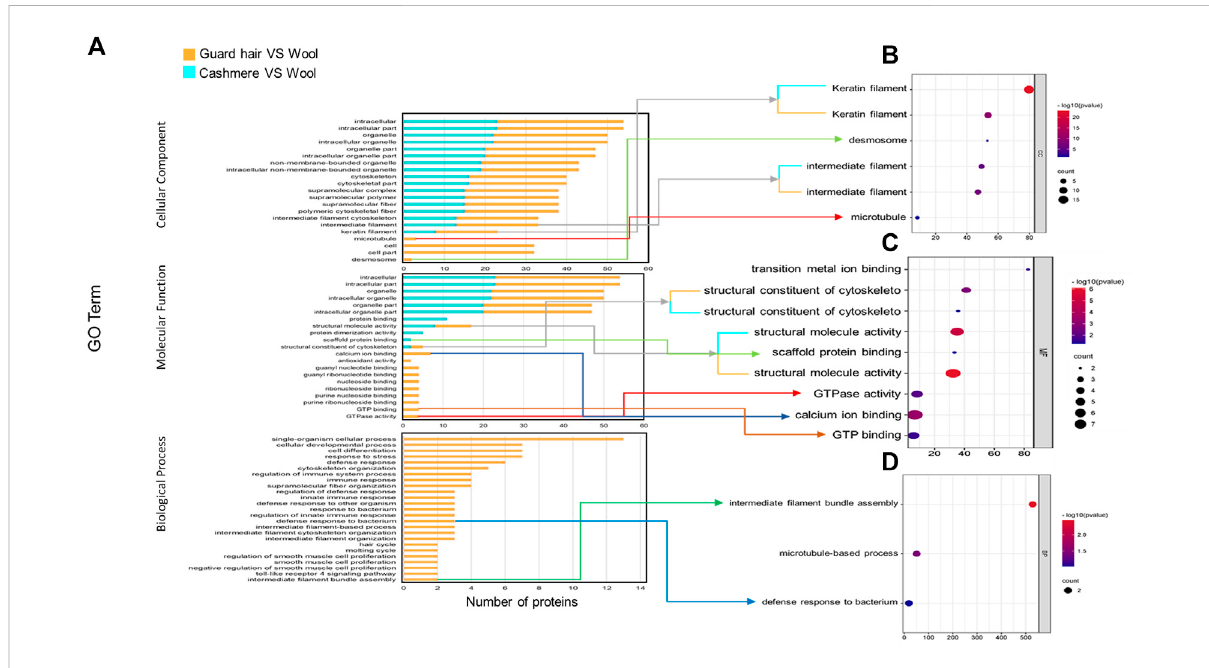
GO enrichment analysis for differentially expressed proteins (DEGs) from cashmere vs wool and guard hair vs wool. (A) . DEPs were enriched in three categories: biological process, molecular function, and cellular component. (B) . Direct GO terms in the cellular component category. (C) . Direct GO terms in the molecular function category. (D) . Direct GO terms in the biological process